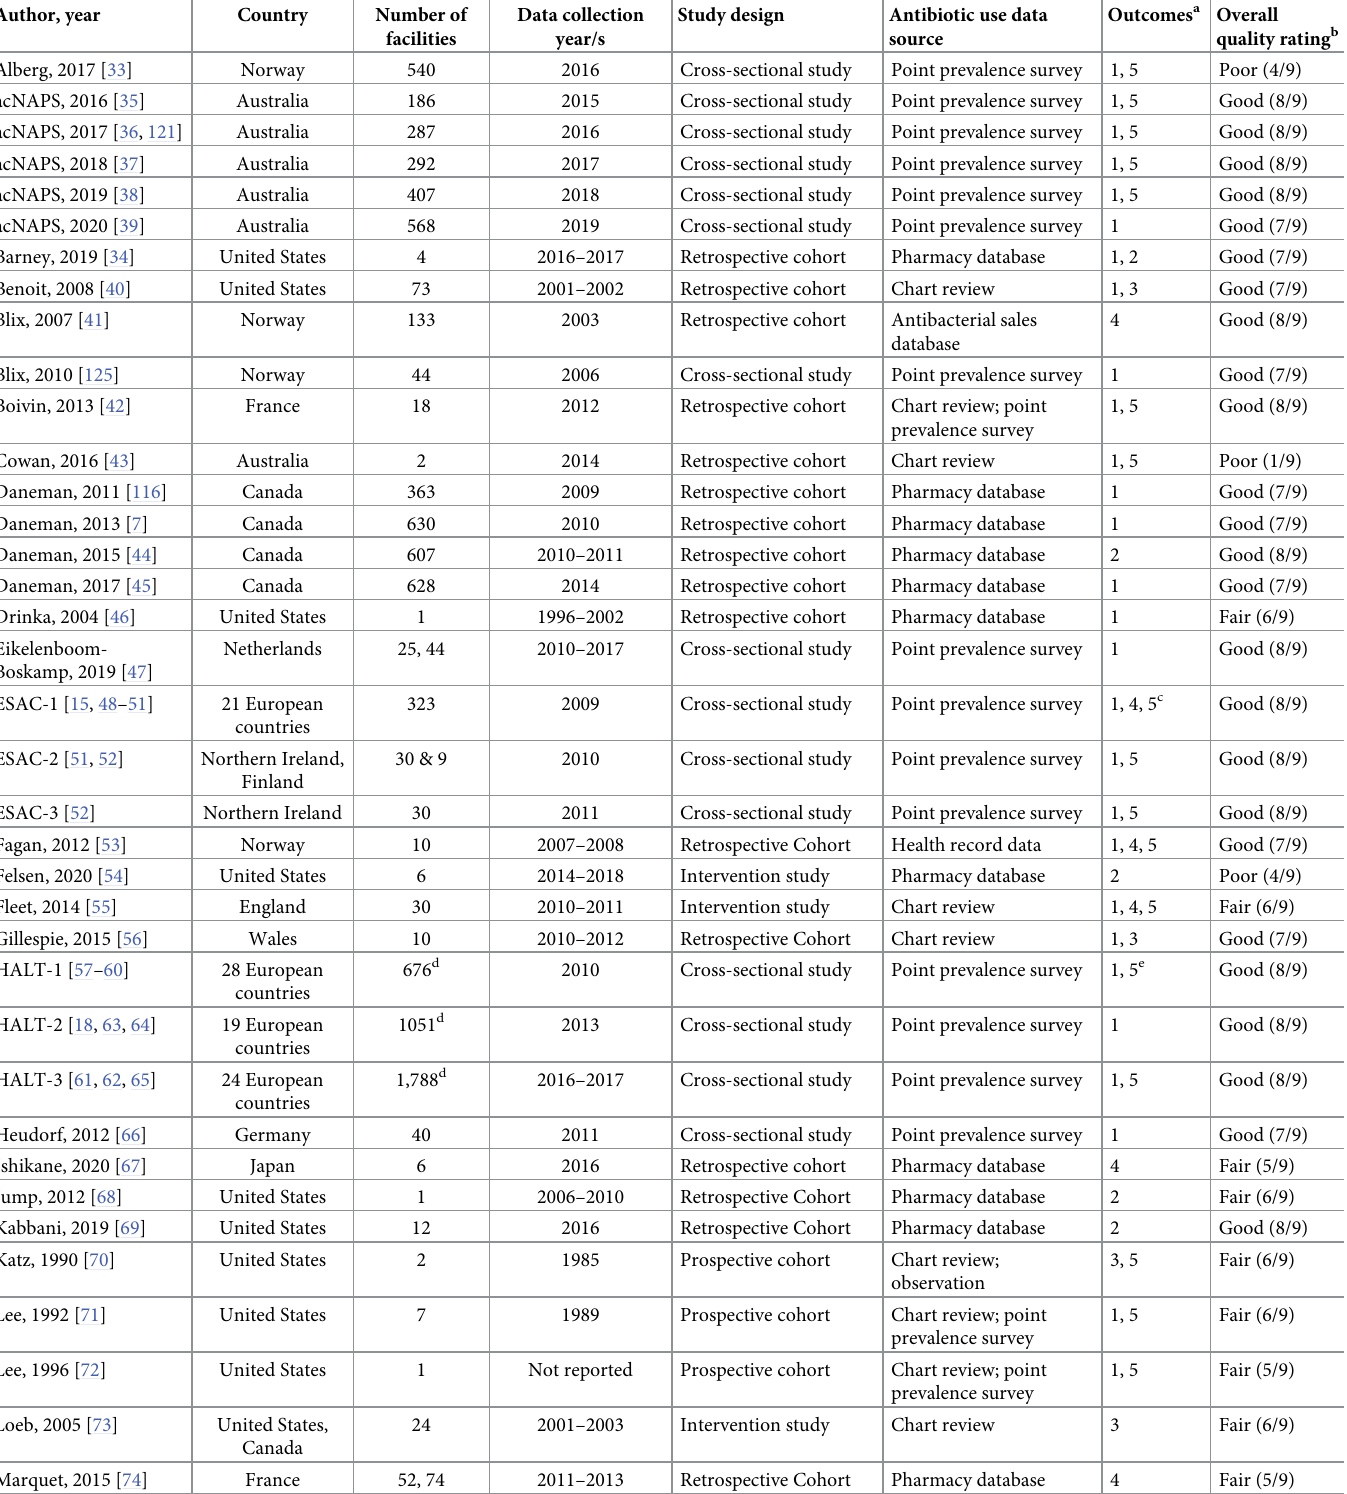
Table 1. Characteristics of included studies measuring the antibiotic use rates in long-term care